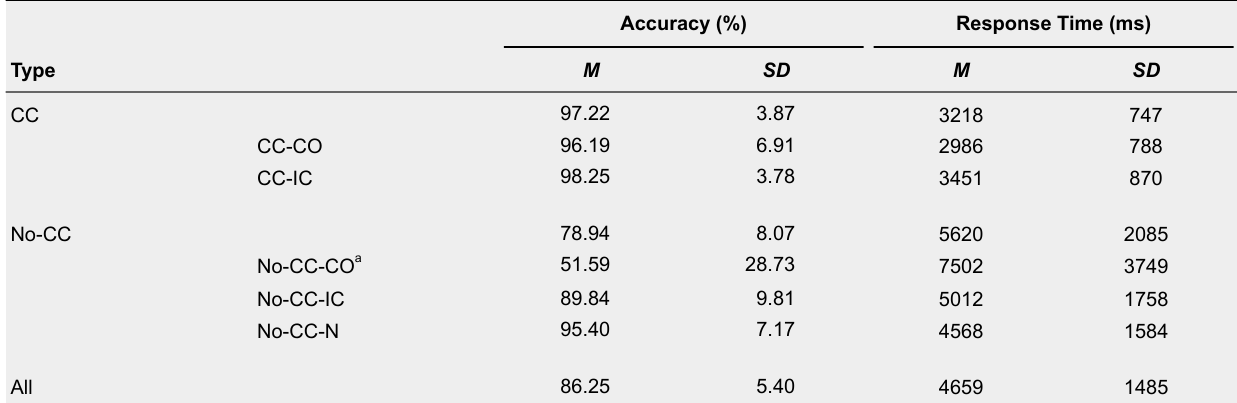
Means and Standard Deviations of Accuracy Rates and Response Times (on Correctly Solved Items), Depending on Problem